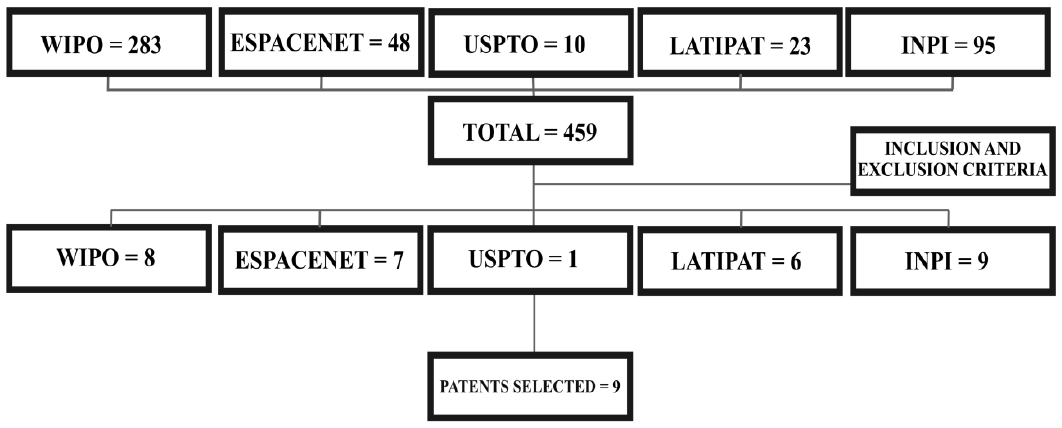
Figure 6. Selection of patents concerning pharmaceutical formulations of Euterpe oleracea Mart. for the treatment and prevention of general diseases. 542